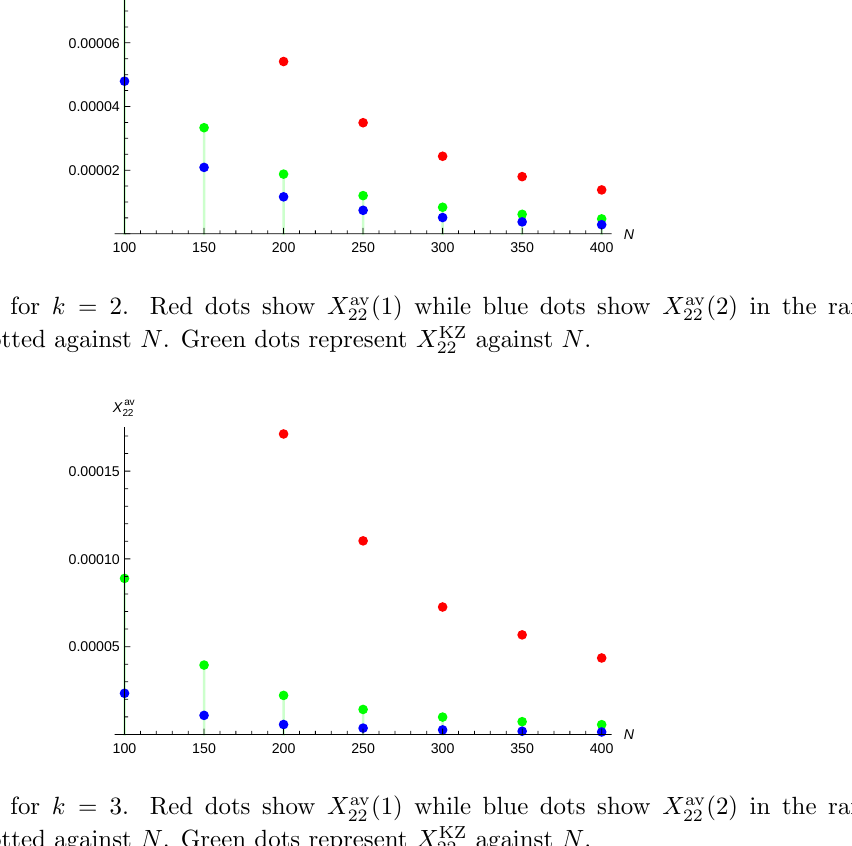
(1) while blue dots show X av (2) in the range 22 22 against N 22